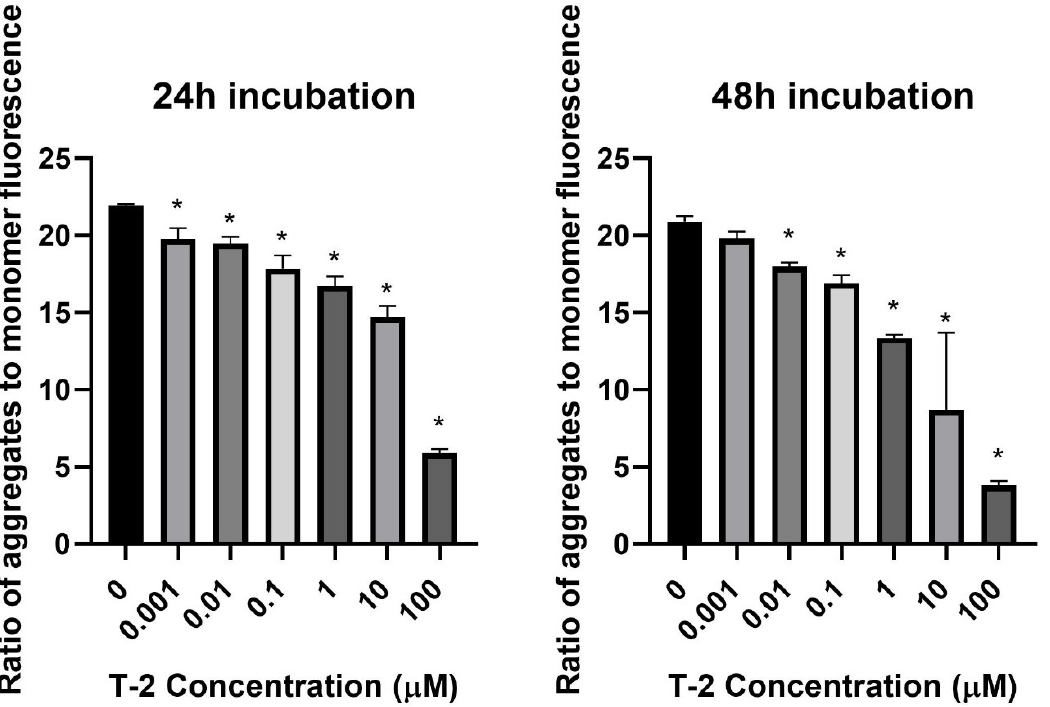
Figure 1. The T-2 toxin effect on the mitochondrial membrane potential of Hs68 cells estimated by the fluorescence dye JC-1 method. The values are presented as means ± SD ( n = 6). * p < 0.5.